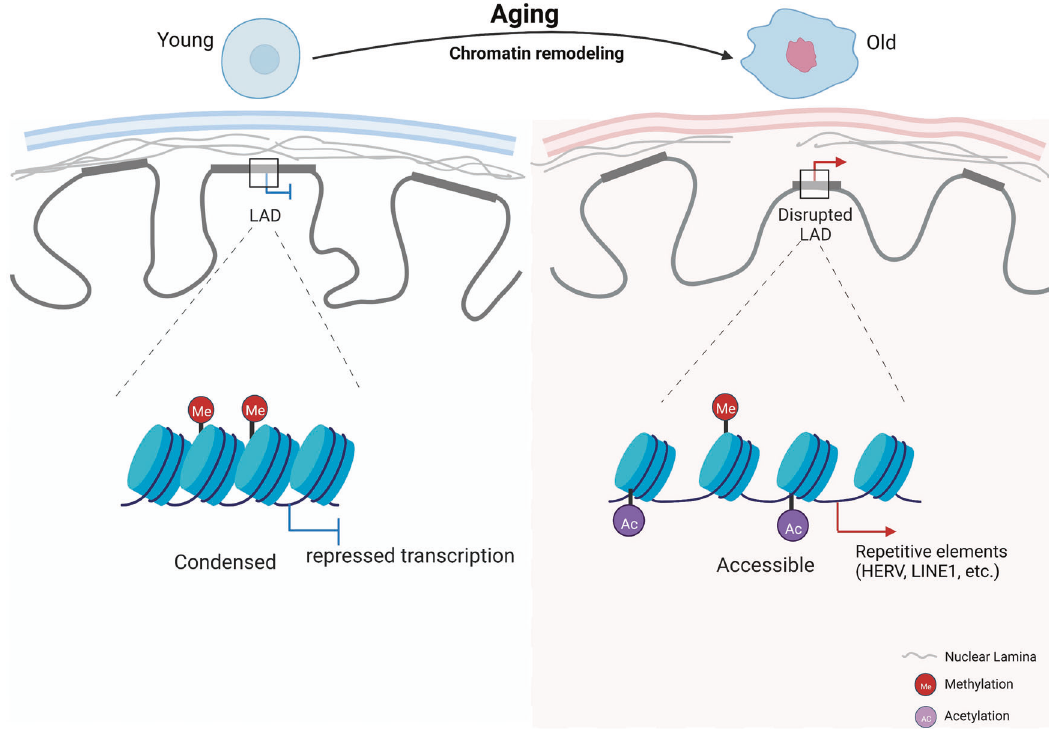
Fig. 4 Chromatin structural remodeling during aging. A general loss of heterochromatin and detachment of lamina-associated domain (LAD) structures from the nuclear lamina occur during this process. Higher-order chromatin structure alterations during aging are accompanied by the redistribution of various histone modi fi cations, including histone methylation (H3K4me3, H3K27me3, H3K36me3, H3K9me3) and acetylation (H3K9ac, H3K56ac, H4K16ac, H3K18ac). This leads to reactivation of repeating sequences and dysregulated gene expression due